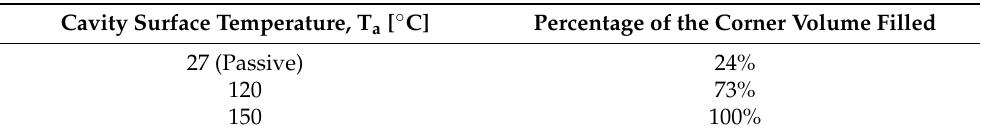
Table 1. Percentage of the corner volume filled by the polymer for the different molding conditions adopted.